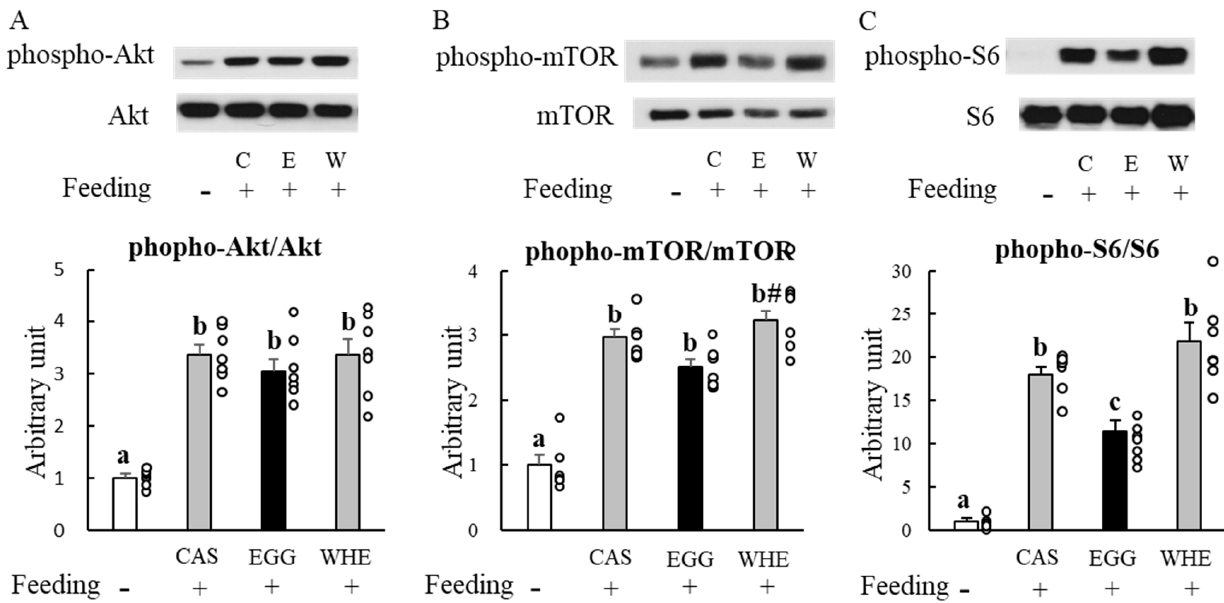
Figure 2. Acute effect of each protein feeding on muscle signal transduction (Day 0). Rats were assigned to either a casein, egg white, or whey protein diet group. After 24-h fasting, rats were allowed a feeding diet containing assigned protein. One hour after the feeding, plantaris muscles were dissected out for western blot analysis of Akt ( A ), mTOR ( B ), or S6 ( C ). The dots beside bars indicate individual value. Values are means ± SE ( n = 7). CAS (C): casein protein, EGG (E): egg white protein, WHE (W): whey protein. Different superscript represents statistical differences among groups. #: p < 0.05 vs. EGG group.